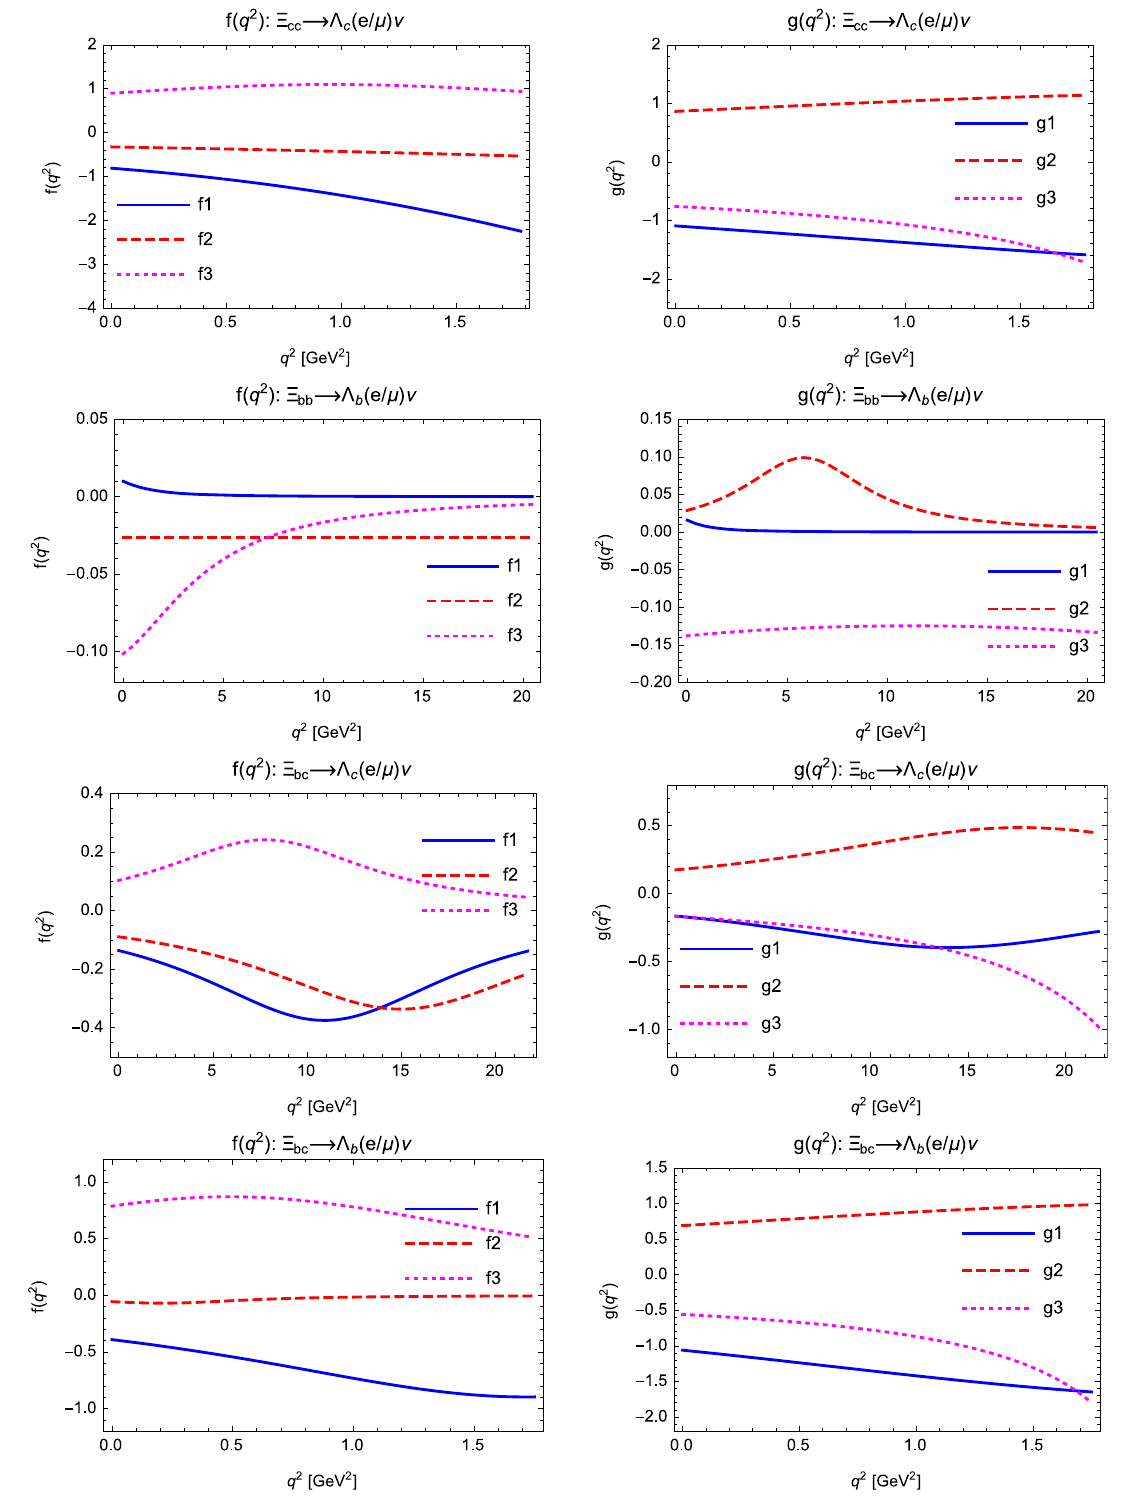
Fig. 2 q 2 dependence of the (cid:3) QQ (cid:3) → (cid:2) Q (cid:3) form factors. The first two graphs correspond to (cid:3) cc → (cid:2) c , the second two graphs correspond to (cid:3) bb → (cid:2) b , the third two graphs correspond to (cid:3) bc → (cid:2) c and the